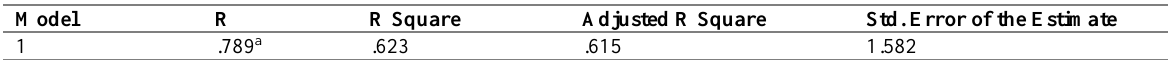
Table 10: Coefficient of